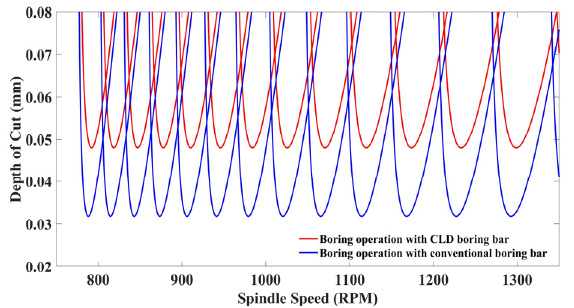
Figure 8. Stability lobe plots for conventional and CLD boring bars